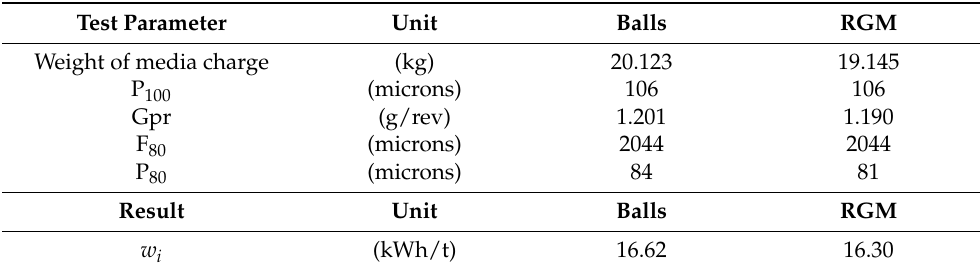
Table 7. Standard Bond grindability tests parameters and results (Test series 1).